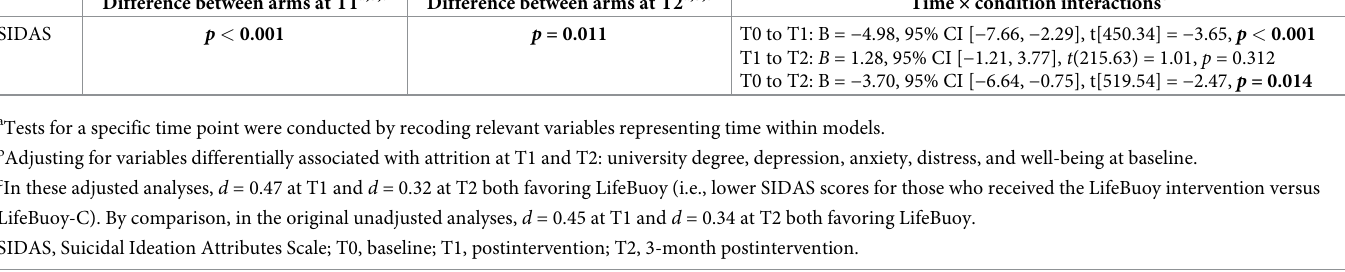
Table 4. Effect of LifeBuoy relative to LifeBuoy-C on the SIDAS after adjustment for baseline variables associated with attrition. Difference between arms at T1 a,b,c Difference between arms at T2